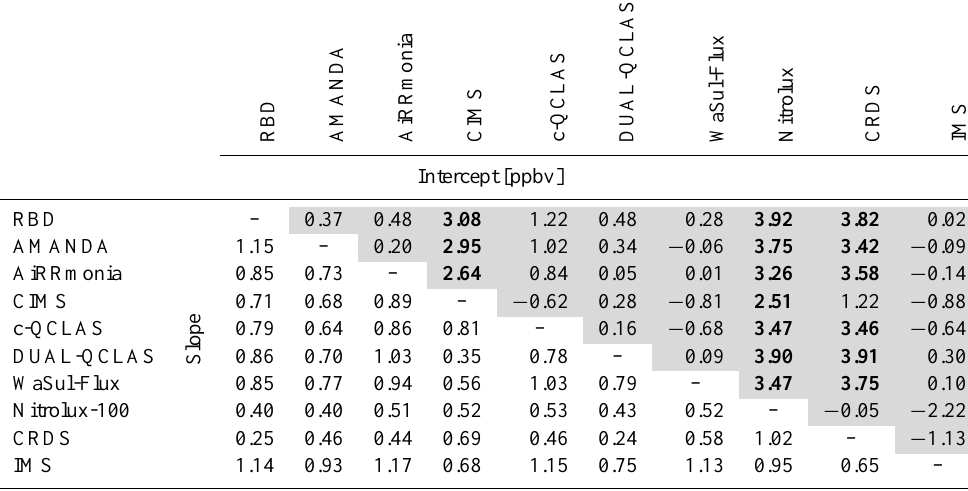
Table 6. Inter-comparison of linear correlations between each instrument of data less than 10ppbv. Slopes are given in the bottom half and intercepts are indicated by the top (grey) of the matrix. Bold numbers indicate noticeable non-zero intercepts ( > 1.5ppbv).